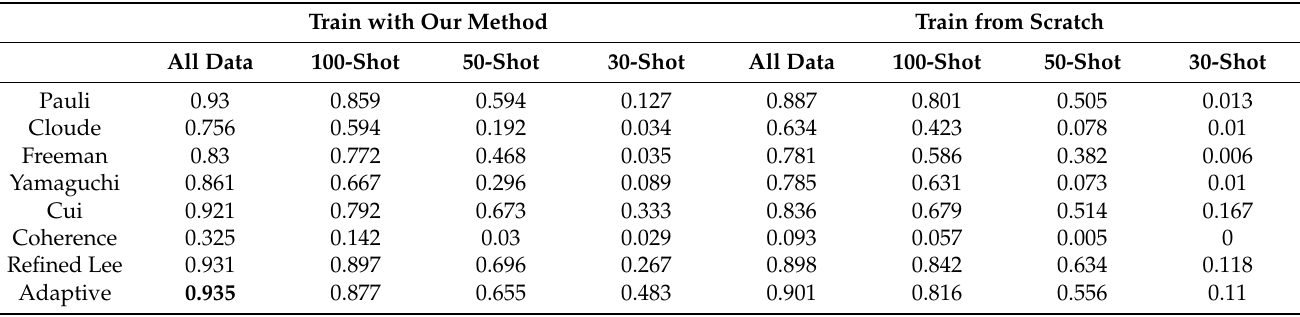
Table 1. Ship detection results (AP) with different input